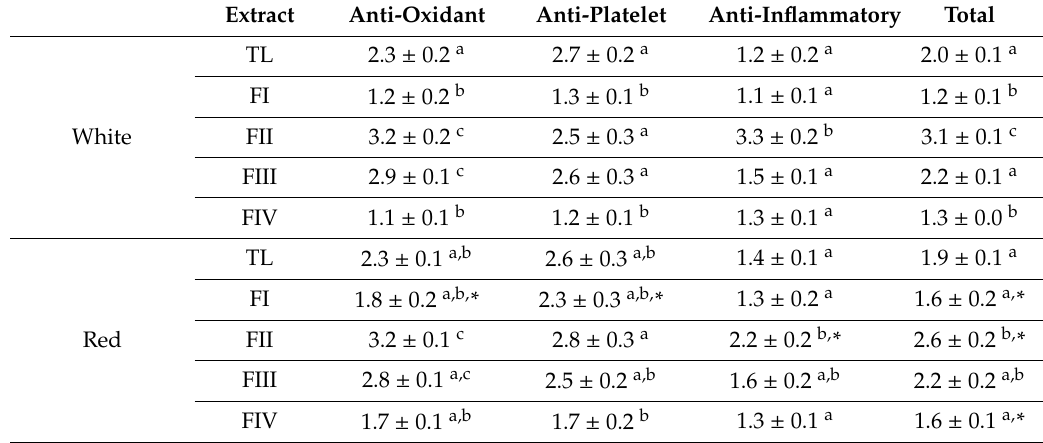
Table 5. Total biological score and per mechanism.